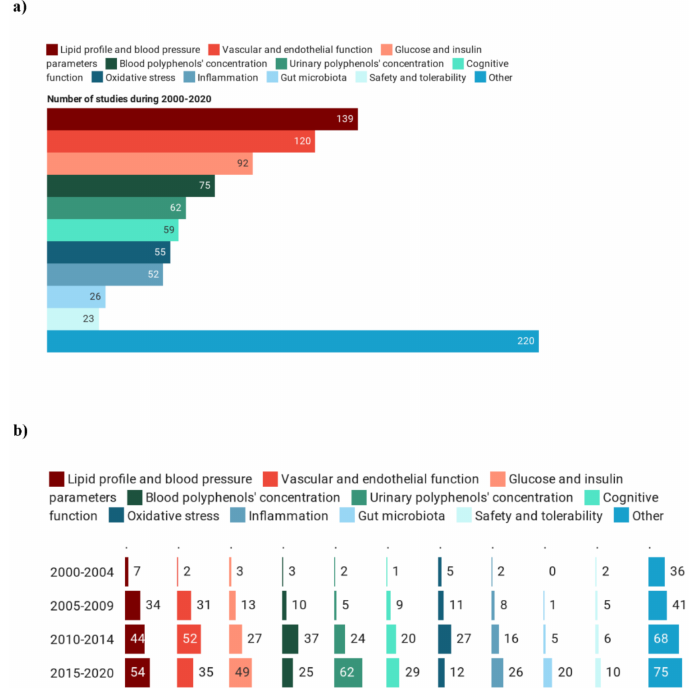
Figure 8. Primary outcomes ( a ) and their trend ( b ) assessed during clinical trials on